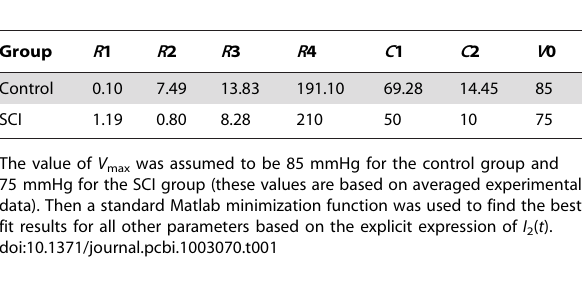
Table 1. Values of the best-fit parameters for control and SCI groups.